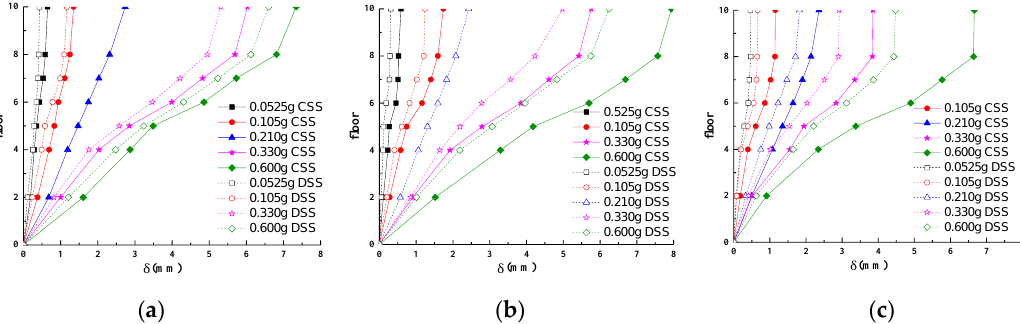
Figure 10. Maximum relative displacements of model structures. ( a ) Under El Centro; ( b ) under Taft; ( c ) under artificial wave.